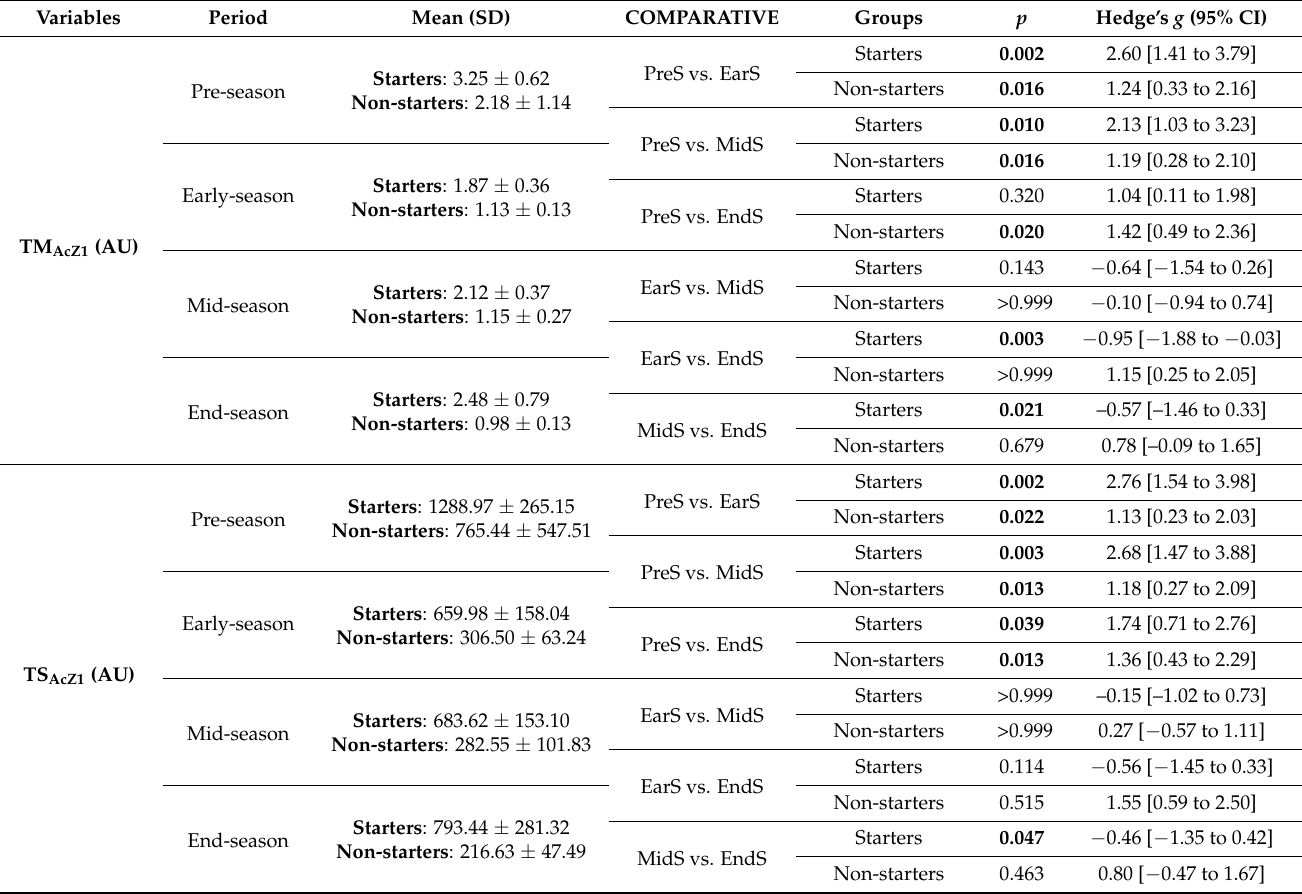
Table 1. Intragroup differences for binary comparisons between season periods in TM and TS in AcZ1 for both non- and starter players.